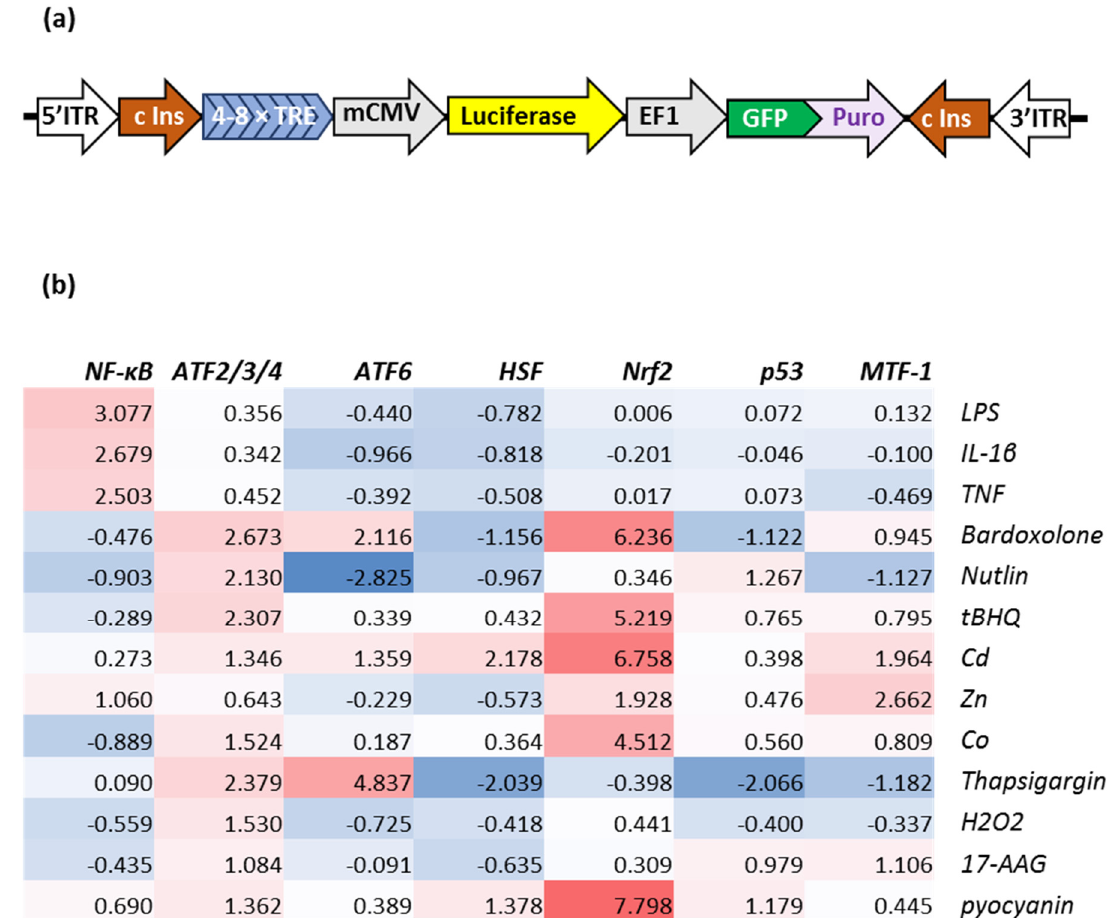
Figure 5. Transcriptional activation assay in rat renal proximal tubular epithelial cell line NRK-52E. ( a ) A general scheme of the reporter construct. Four to eight specific transcription factor binding sequences (transcription factor response elements, TREs) and the mCMV promoter regulate reporter luciferase, while the EF1 promoter provides for constant production of destabilized GFP and puromycin resistance selector. The flanking core insulators protect from epigenetic silencing of the reporter, while the piggyBac transposon ITRs secure accurate and efficient insertion of the reporter into the genomic DNA. ( b ) Heatmap of the reporter activation, expressed as log 2 (induction fold), to common inducers and inhibitors used to validate specificity of the reporters. See extended Supplementary Materials Table S14 for viabilities and SDs. Concentrations: lipopolysaccharide (LPS)—200 ng/mL; interleukin-1 β (IL-1 β )—10 ng/mL; tumor necrosis factor (TNF)—10 ng/mL; bardoxolone (CDDO-Me)—500 nM; nutlin—25 μ M; tert-butyl hydroquinoline (tBHQ)—20 μ M; CdCl 2 —10 μ M; ZnSO 4 —100 μ M; CoCl 2 —250 μ M; thapsigargin—50 nM; hydrogen peroxide (H 2 O 2 )—240 μ M; tanespimycin (17-AAG)—250 nM; pyocyanin—80 μ M.